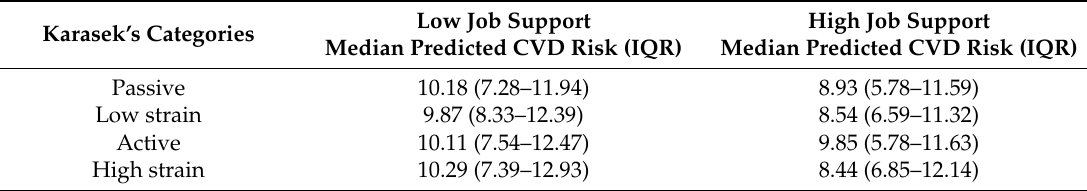
Table 9. Median Predicted CVD risk score in the four Karasek’s categories and the two job support categories, based on the linear regression model presented in Table